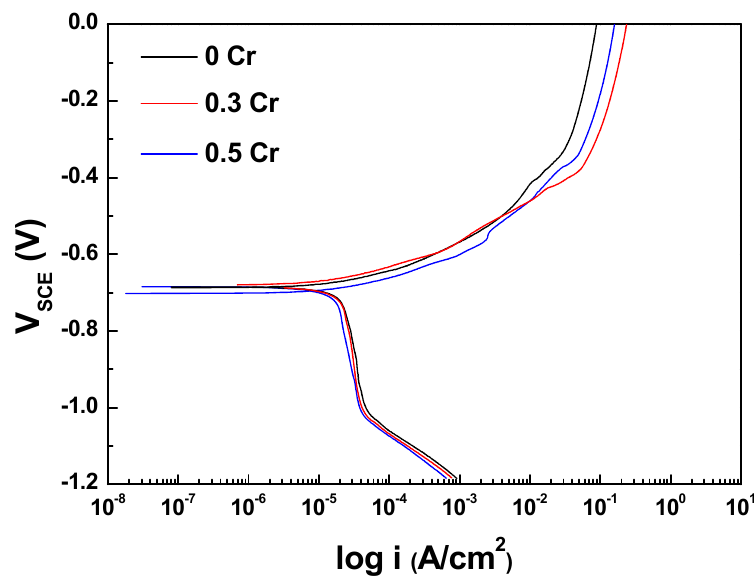
Figure 3. Potentiodynamic polarization curves in 3.5 wt.% NaCl solution. Table 2. Potentiodynamic polarization test results in 3.5 wt.% NaCl solution.